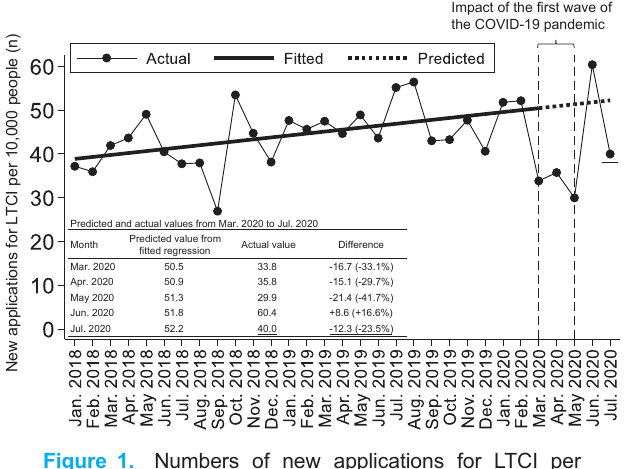
Figure 1. Numbers of new applications for LTCI per